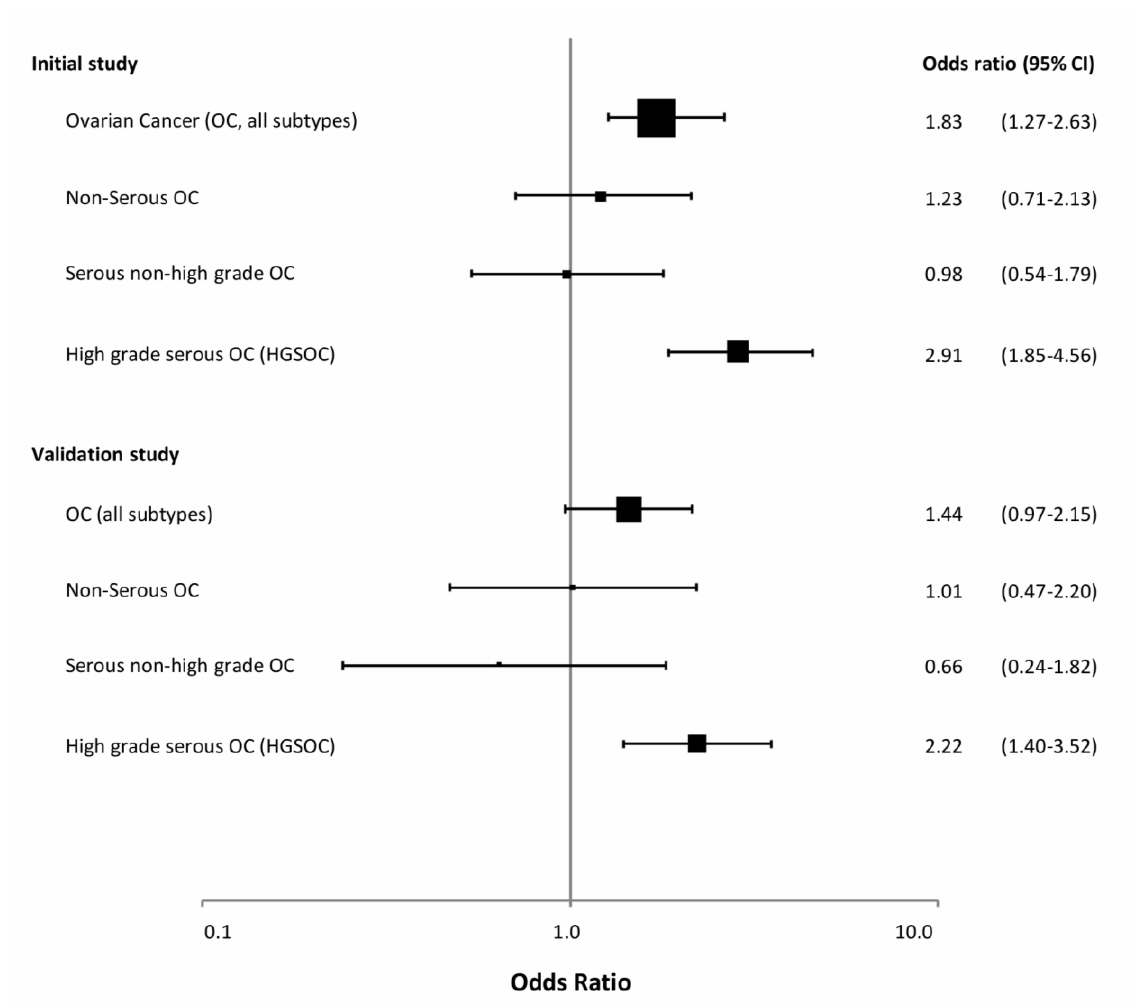
FIGURE 2: BRCA1 methylation and risk of ovarian cancer. Forest plot illustrating the odds ratio (OR) for ovarian cancer (all subtypes), non-serous, serous non-high grade and high grade serous ovarian cancer (HGSOC) related to BRCA1 promoter methylation, derived from the initial study population and the validation cohort in the recent publication by Lønning et al . [131]. The odds ratios (ORs) were based on analyses of 925 cases and 1688 controls (initial study) and 607 cases and 1914 controls (validation study). Reprint of original figure, with permission from Annals of Internal